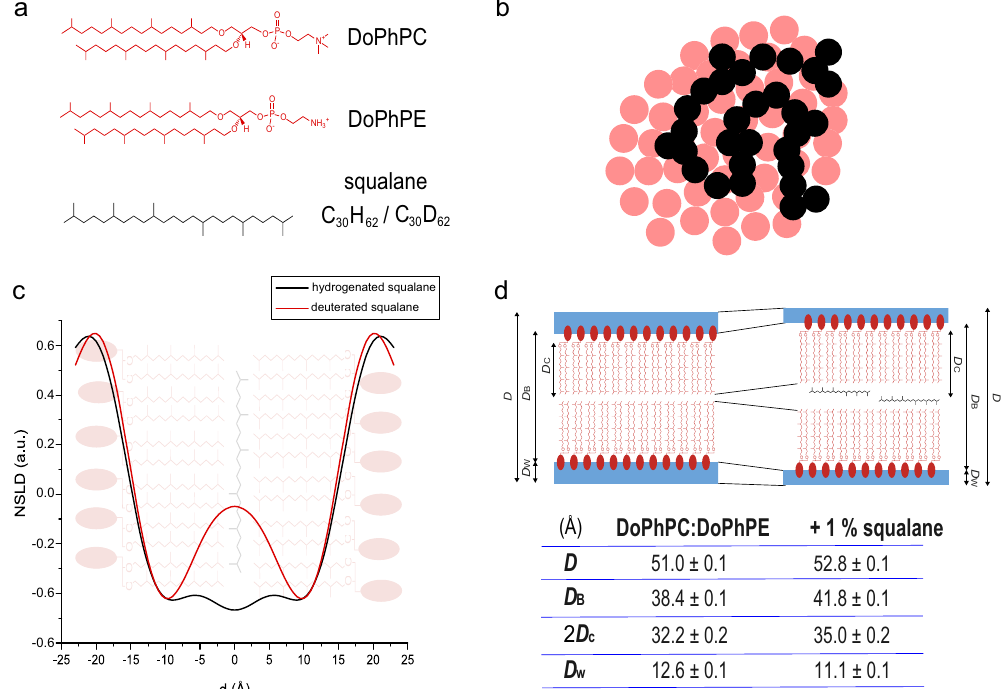
Fig. 2 Apolar isoprenoid molecules as structural membrane components placed in the midplane bilayer. a Skeletal formula of the lipids used: 1,2-di-O- phytanyl- sn -glycero-3-phosphocholine (DoPhPC), 1,2-di-O-phytanyl- sn -glycero-3-phosphoethanolamine (DoPhPE), and 2,6,10,15,19,23- hexamethyltetracosane (squalane), hydrogenated, and deuterated. b Sketch of a top view of the interaction of the apolar lipid squalane (methyl groups represented as black spheres) in the midplane of the reconstructed archaeal-like lipid bilayer membrane (lipid isoprenoid chain extremities are represented in red). c Neutron scattering length density (NSLD) of DoPhPC:DoPhPE (9:1) + 1 mol% hydrogenated squalane (black) and deuterated squalane (red) measured on D166 (ILL, Grenoble, France). d Structural parameters: lamellar repeat spacing (D), bilayer thickness (D B ), hydrocarbon region thickness (2D C ), and water layer thickness (D w ) for bilayers of DoPhPC:DoPhPE (9:1) in the absence and presence of 1 mol%